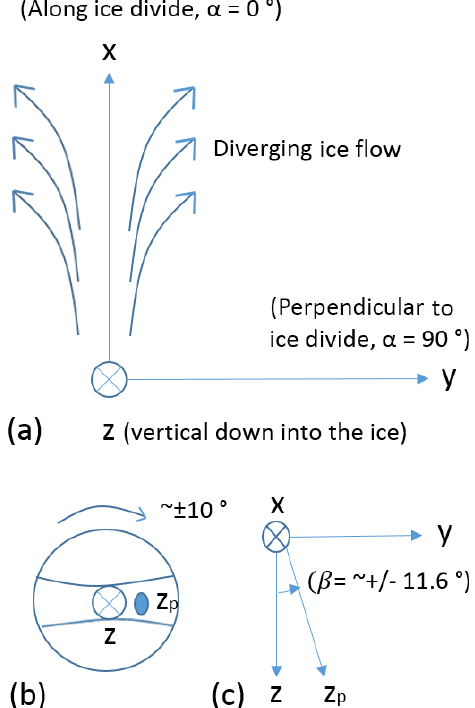
Figure 12. Illustration of the major findings from the multi- polarization radar measurements. (a) Diverging ice flow scenario at ice divide; (b) sketch of girdle COF formed by diverging ice flow in which the point z p is the projection of the ice optic axis, and rotation arrow indicates the spatial variations of the ice fabric orien- tation around the NEEM site; (c) the average tilt angle of ice optic axis z p at the NEEM